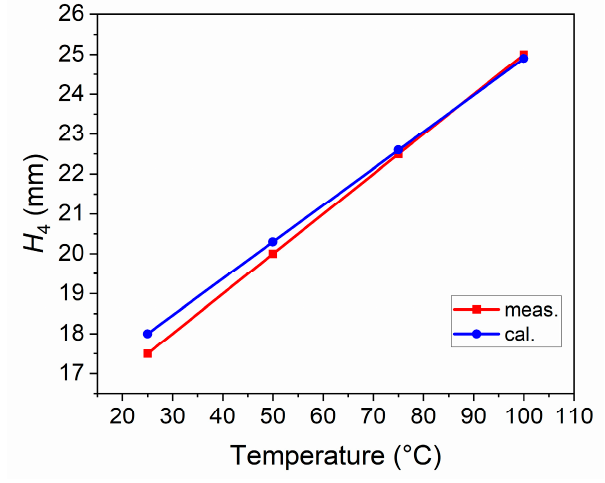
Figure 5. The lengths of H 4 at different temperatures.